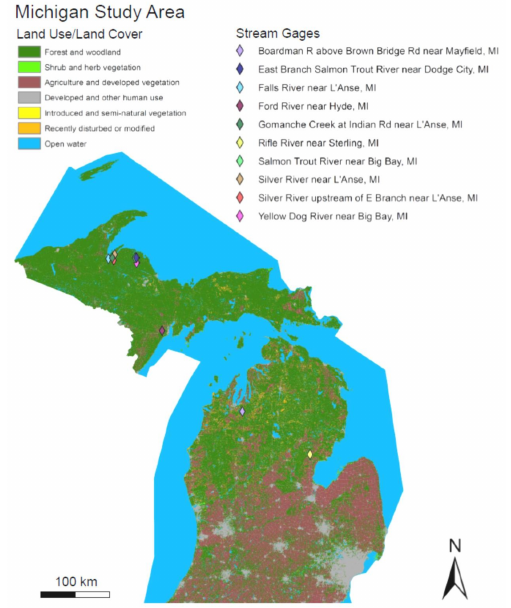
Figure 1. State of Michigan, land use and U.S. Geological Survey (USGS) stream gages that fit outlined selection criteria for undisturbed